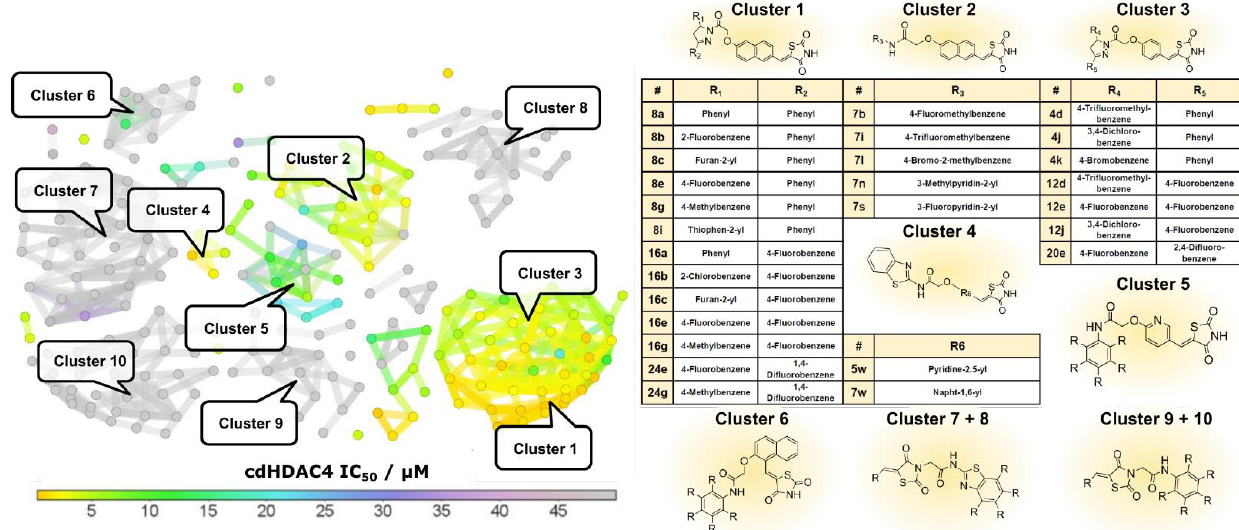
Figure 1. Similarity map for structural activity relationship analysis for 225 TZD containing compounds. The similarity map revealed ten clusters with varying inhibitory potencies towards cdHDAC4 wt . Marker color and connecting lines highlight inhibitory activity and similarity pairs, respectively. Filled gray circles represent inactive TZD ligands with IC 50 -values > 50 µM.